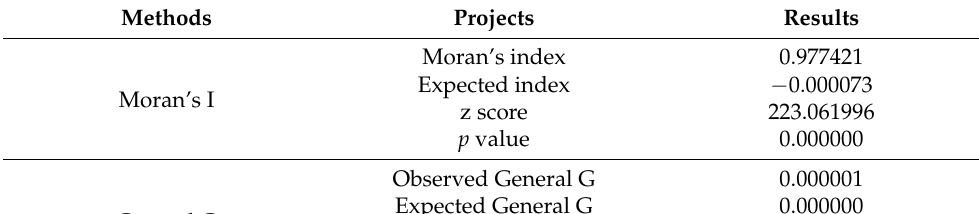
Figure 4. Results of spatial autocorrelation analysis: ( a ) Moran’s I results; ( b ) general G results). Table 1. List of Moran’s I and General G analysis results.